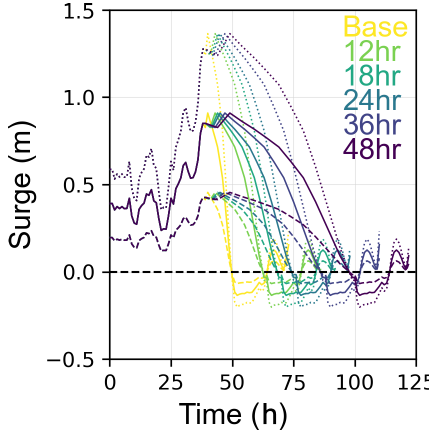
Figure 4. Dune volume versus dune aspect ratio measured from LiDAR profiles from Bogue Banks, NC, USA, collected between 1997–2016. The red box represents the range of conditions simu- lated in this study.